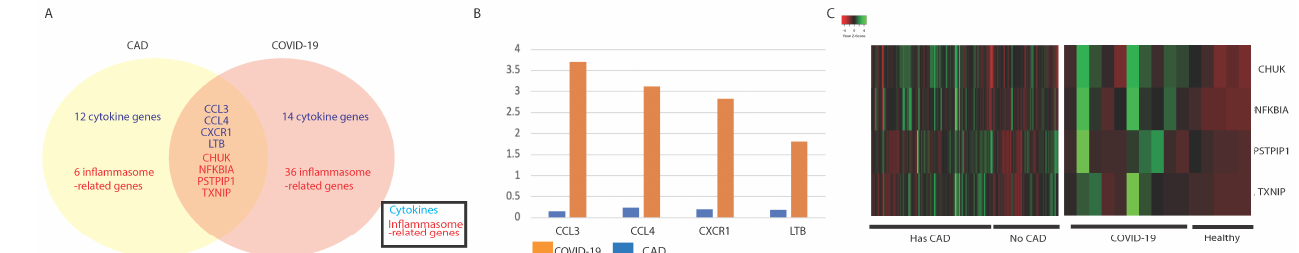
Figure 4. Comparing coronary artery disease (CAD) and COVID-19 patients. ( A ) Summary of commonly dysregulated cytokine- and inflammasome-related genes in COVID-19 and CAD patients. Cytokines are in blue and inflammasome- related genes are in red. ( B ) Bar plots of the log2 fold change of significantly dysregulated cytokine genes in COVID-19 and CAD patients. ( C ) Heatmaps of inflammasome-related genes in COVID-19 and CAD patients.